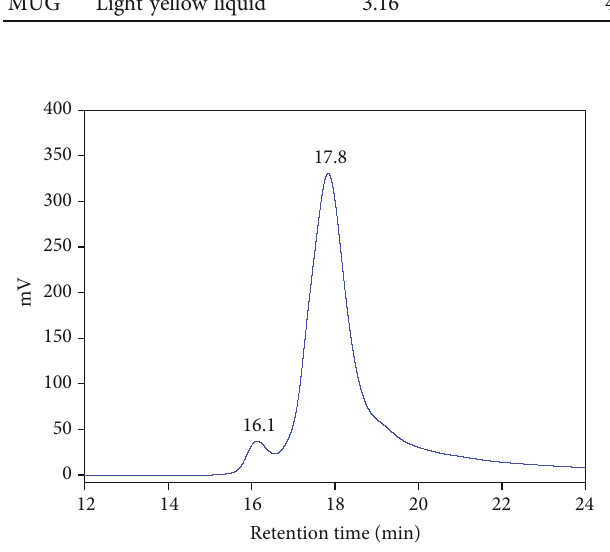
Figure 2: Typical GPC chromatograms of the MUG resin. M Table 2: M n , w , PDI, and peak area proportion of MUG resin. M n (g/Mol)